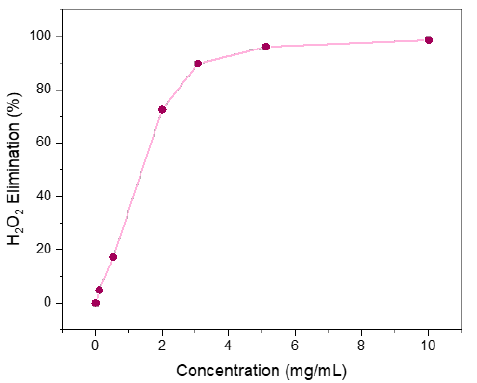
Figure 8. Hydrogen peroxide evolution against the Mn-Nanozyme concentration.